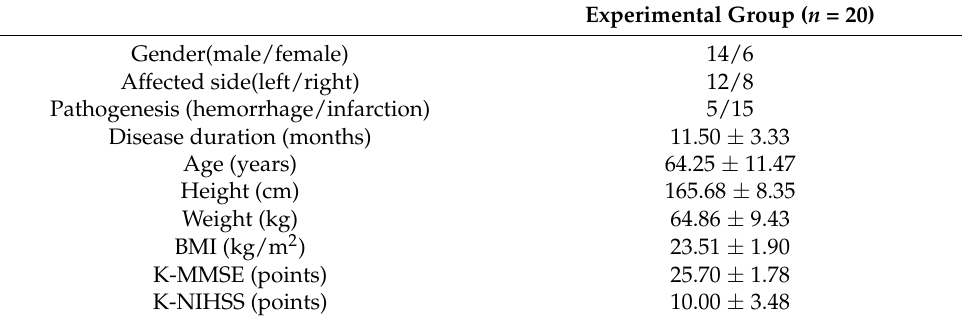
Table 1. General characteristics of the